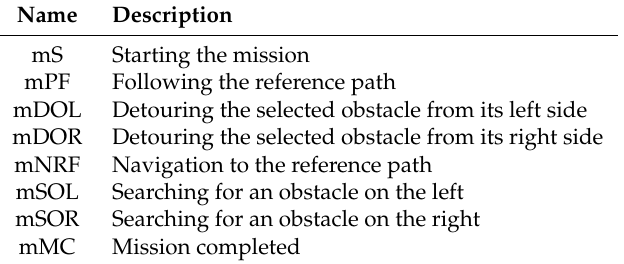
Table 1. States of the discrete-event system (DES).